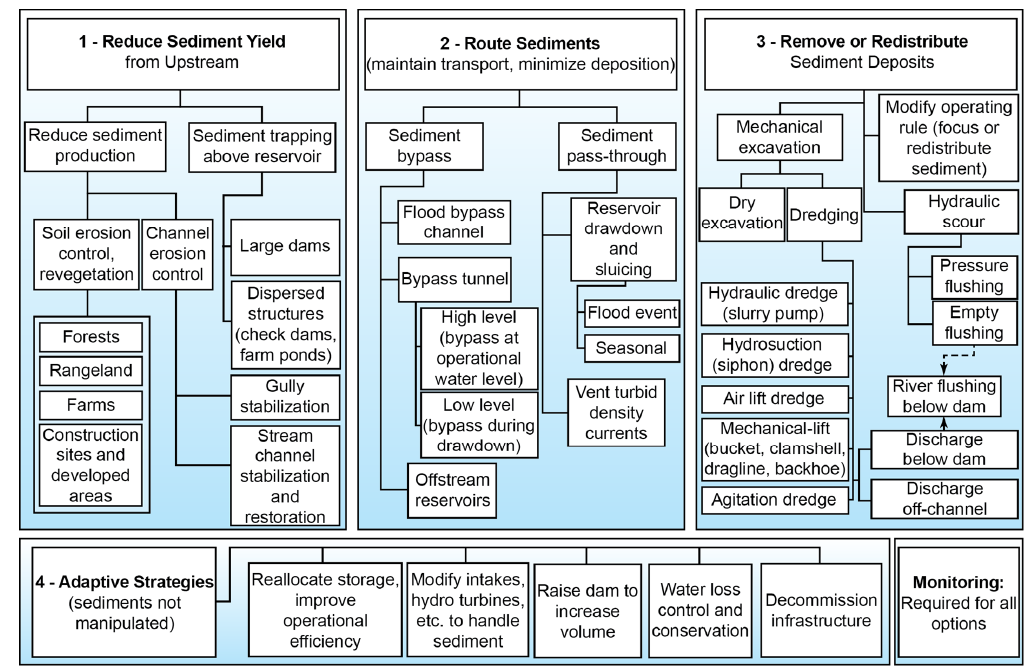
Figure 1. Classification of methods to manage reservoir sedimentation, Reproduced with permission from [9] .